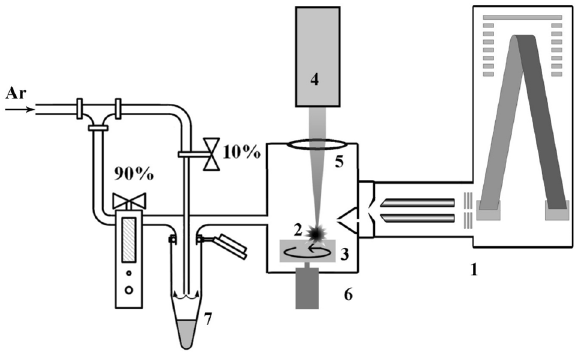
Figure 1. Schematic diagram of the laser mass spectrometer: 1—reflectron time-of-flight mass analyzer (m/∆m = 5000), 2—laser plasma, 3—rotating metal target, 4—diode-pumped Nd:YAG laser (pulse